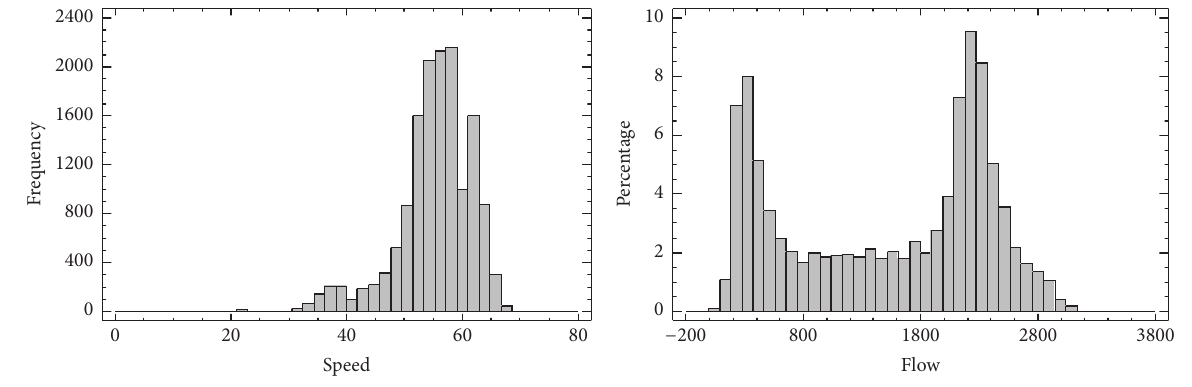
Figure 3: Traffic speed and flow histograms.